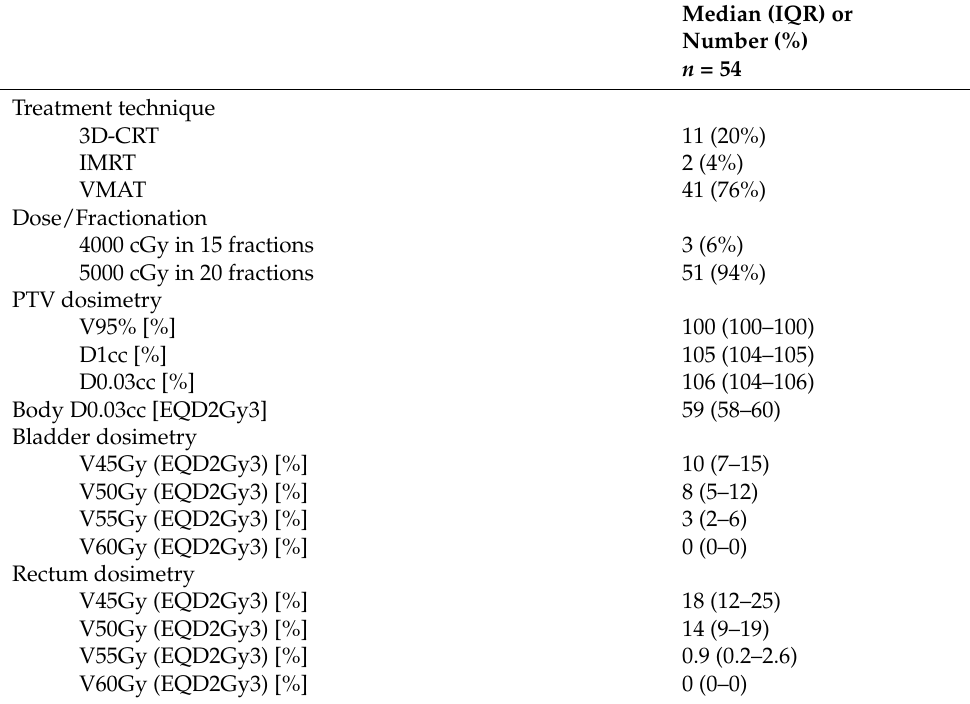
Table 2. Radiotherapy treatment characteristics for 54 elderly patients with prostate